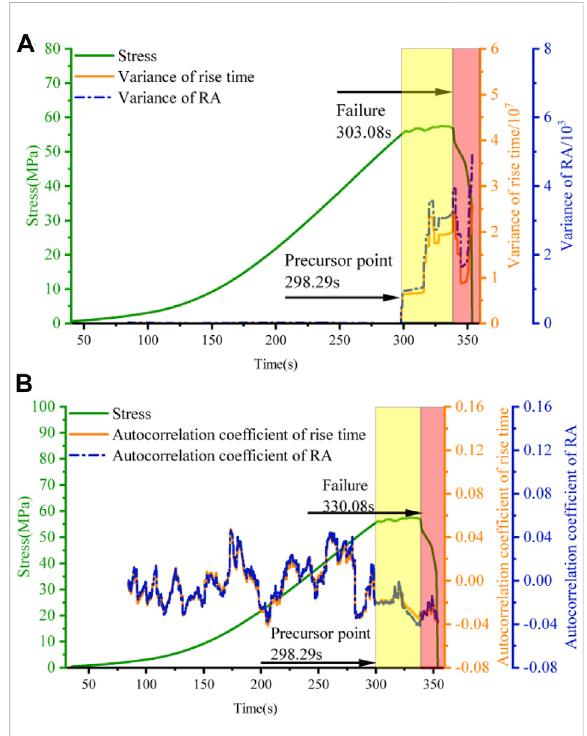
FIGURE 7 Characteristics of the CSD indicators of the autoregression model of the w-1 rock sample. (A) variance characteristics of RA and rise time and (B) autocorrelation coef fi cient characteristics of RA and rise